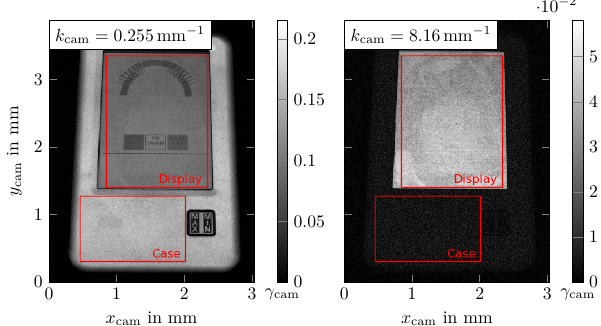
Figure 20. Measurements of γ cam for different pattern frequencies under dark